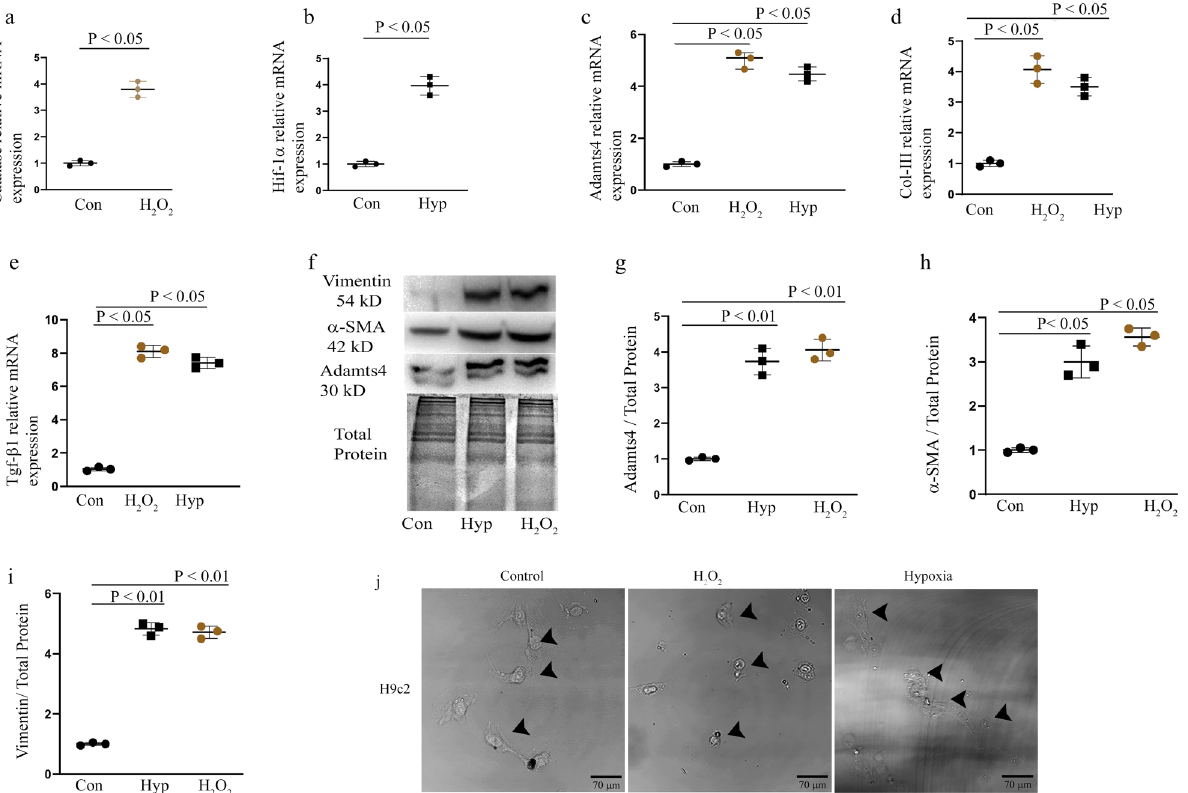
Figure 3. Injury induced overexpression of Adamts4 and fibrosis related markers in H9c2 cells. Relative mRNA expression assessed by quantitative real-time PCRs of Catalase ( a ) shows an upregulation by 3.8 fold, Hif-1α ( b ) was found to be elevated by fourfold, Adamts4 ( c ) was found to be upregulated by 5 and 4.5 fold for H 2 O 2 and Hyp treatment sets respectively, Col-III ( d ) was found to be elevated by 4 and 3.5 fold H 2 O 2 and Hyp treatments, Tgf-β1 ( e ) levels were upregulated by 8 and 7.4 folds for H 2 O 2 and Hyp treatments respectively. Also, elevated expression of proteins analyzed by WB with Adamts4 ( f and g ) showed an enhanced expression of 3.7 and fourfold for Hyp and H 2 O 2 treatments, α-SMA ( f and h ) showed an upregulation of 3 and 3.5 folds Hyp and H 2 O 2 treatment groups, Vimentin ( f and i ) under stress induced conditions of hypoxia and H 2 O 2 showed upregulated expression by 4.8 fold for hypoxia and 4.7 fold for H 2 O 2 treatments. Elevated expression of markers- Catalase and Hif-1α signified successful injury inductions while upregulated expressions of Adamts4, Col-III, Tgf-β1, α-SMA and Vimentin indicated development of injury related fibrosis. ß-actin was used to normalize gene expression for qPCR assay and total protein was used as loading control for WB. n = 3. Data analyzed and expressed as mean ± SD. Differences were considered statistically significant for p < 0.05. ( j ) H9c2 morphology after injury induction as compared to control taken with the help of a DIC